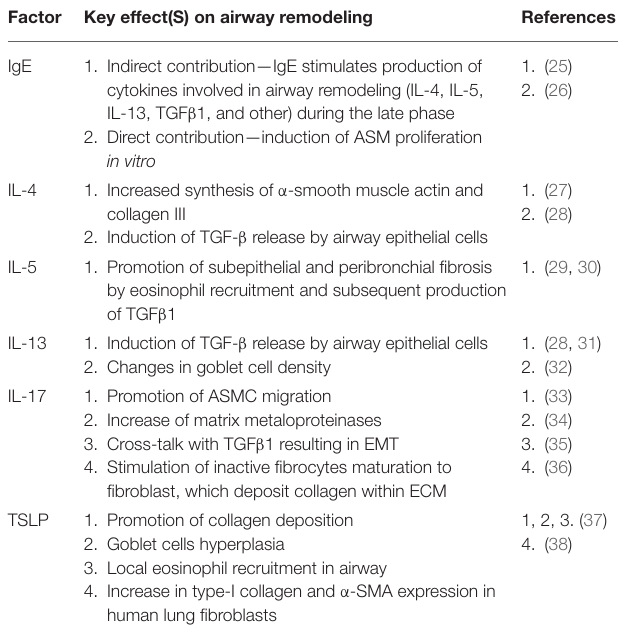
TABLE 1 | Key molecular factors contributing to airway remodeling (in particular—the factors that are aimed by currently available or investigated biological therapies of